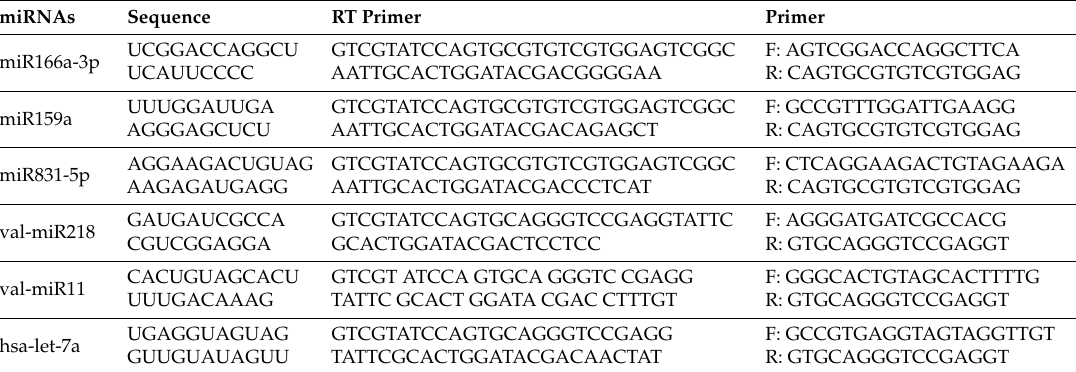
Table 4. Primers for stem-loop